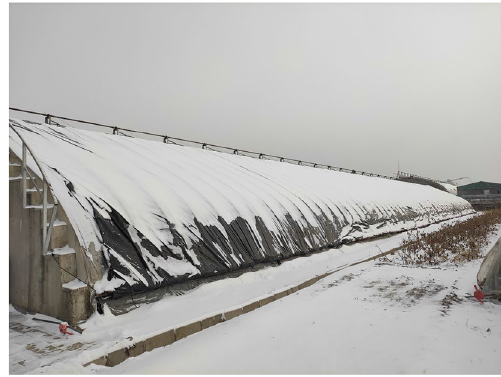
Figure 4. Field picture of greenhouse snow